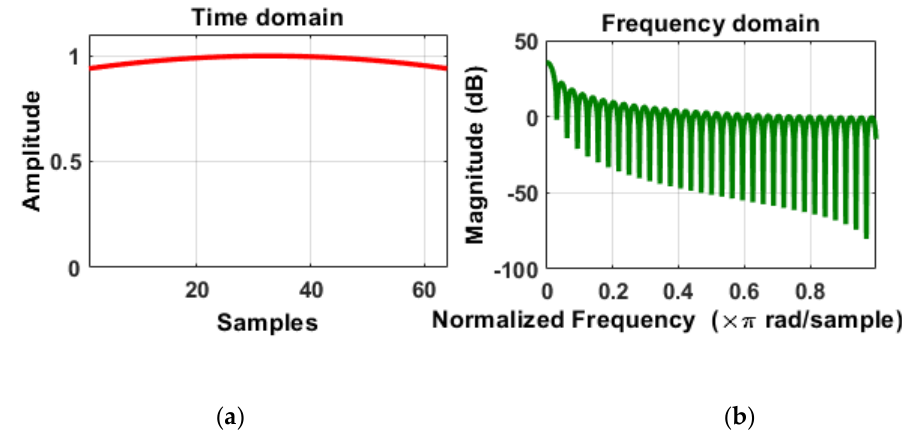
Figure 10. Kaiser window in ( a ) the time domain and ( b ) the frequency domain, representing a length of 64 in the time domain.